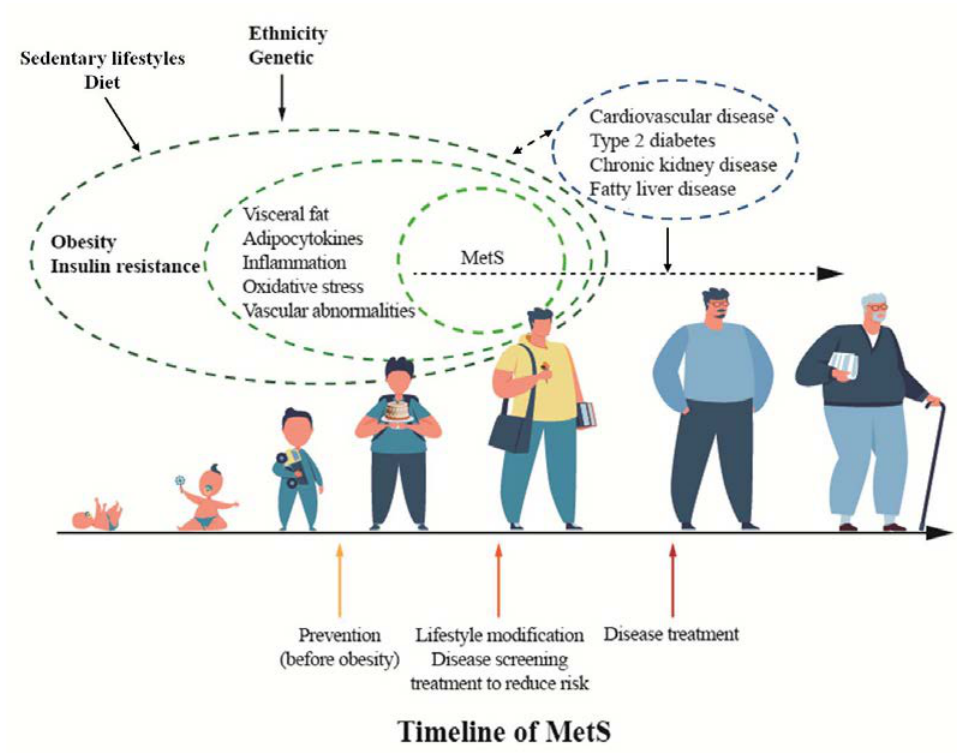
Figure 1. Timeline of metabolic syndrome (MetS).